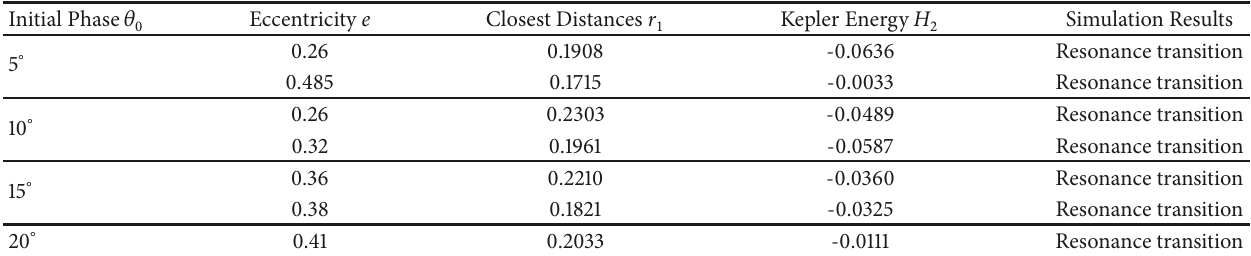
Table 2: Simulation results for 1:2 resonant orbits whenthe initial parametersdefine the closestdistance as 𝑟 ROI ≤ 𝑟 1 ≤ 𝑟 Hill Kepler energy H 2 ≤ 0.